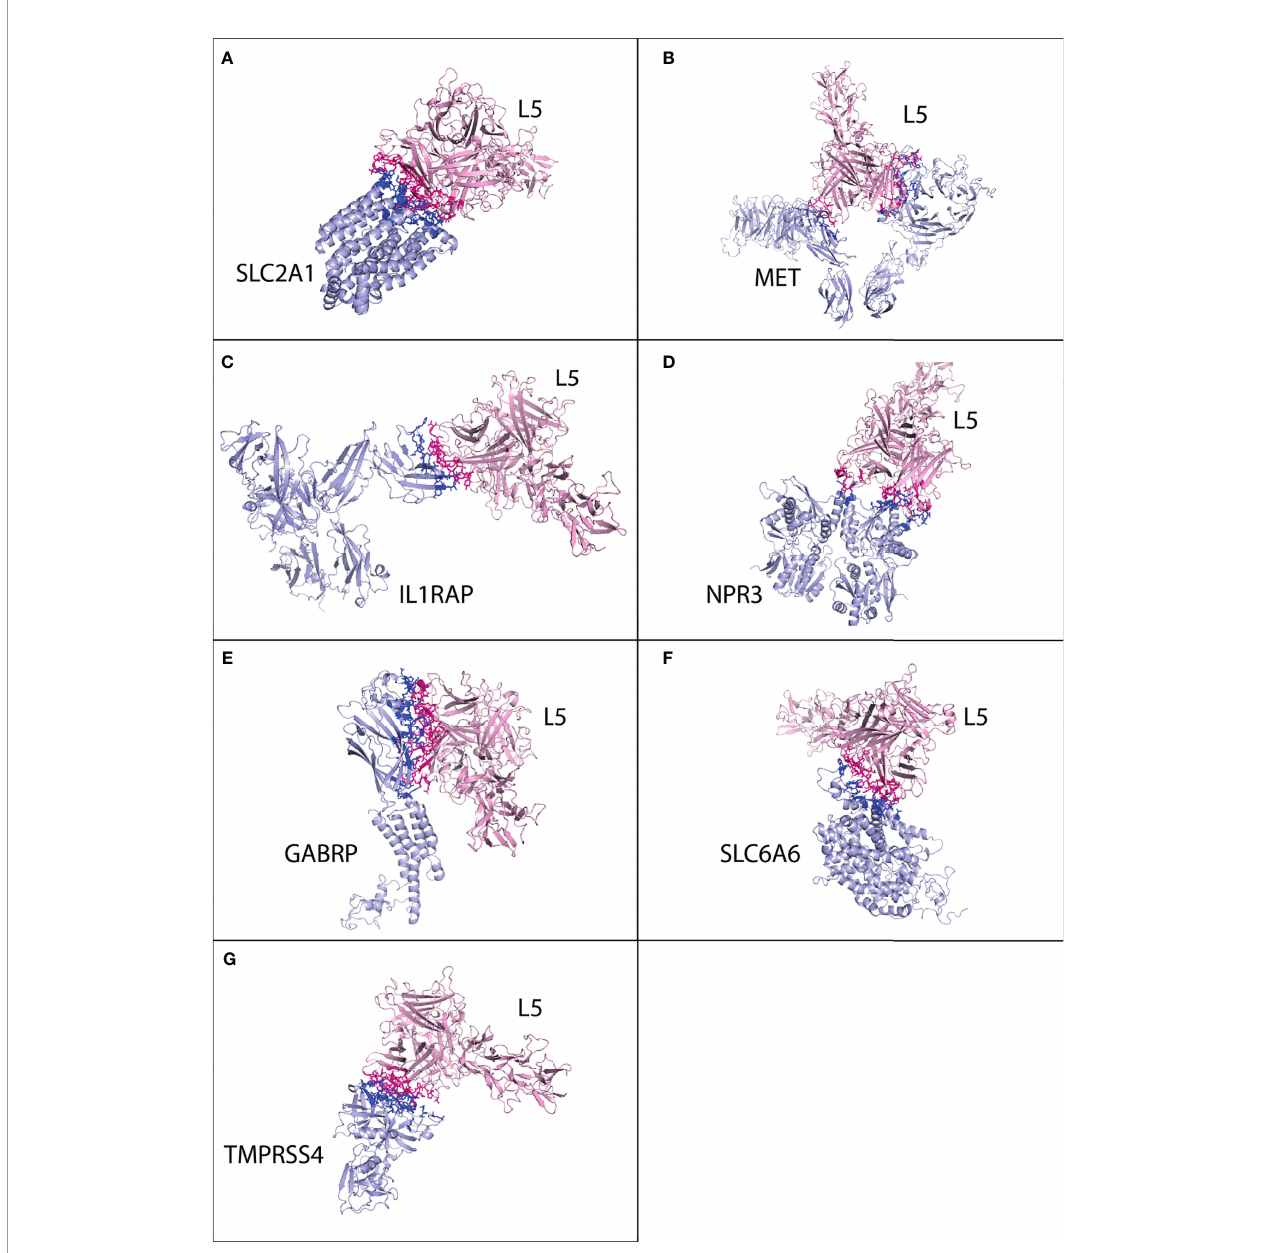
FIGURE 2 | Protein – protein interaction complex of HAdV2 L5 protein with pancreatic cancer receptors. The pink ribbon represents L5 protein, while purple ribbons represent cancer receptors. The interacting residues are shown by a stick, L5 protein is shown in dark pink, and receptor is shown in dark blue. (A) SLC2A1 made a total of 141 interactions. (B) MET generated 76 interactions. (C) IL1RAP made 75 interactions. (D) NPR3 made 78 interactions. (E) GABRP made a total of 169 contacts. (F) SLC6A6 made 84 interactions. (G) TMPRSS4 made 119